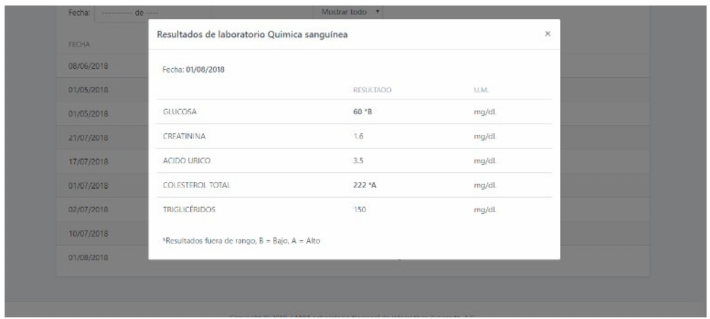
Figure 39. Patient application interface: Laboratory result module and blood chemistry test